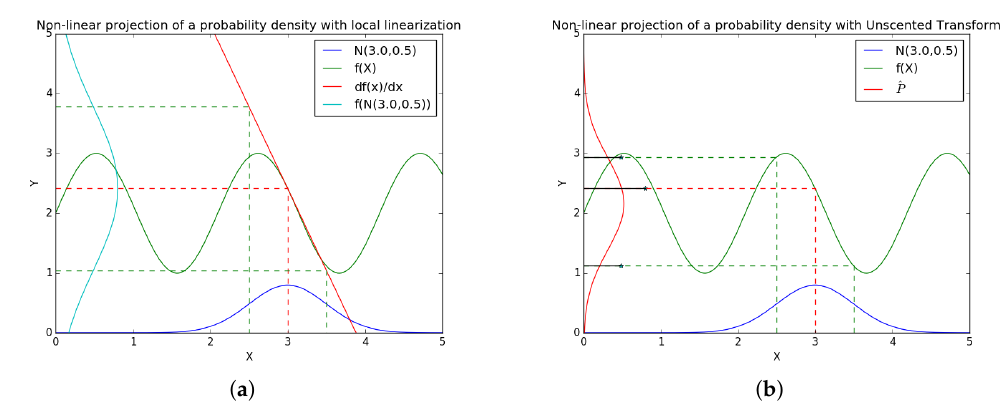
Figure 3. Non-Linear projection methods for: ( a ) local linearization system (EKF projection); and ( b ) non-linear weighted projections (Unscented Transform